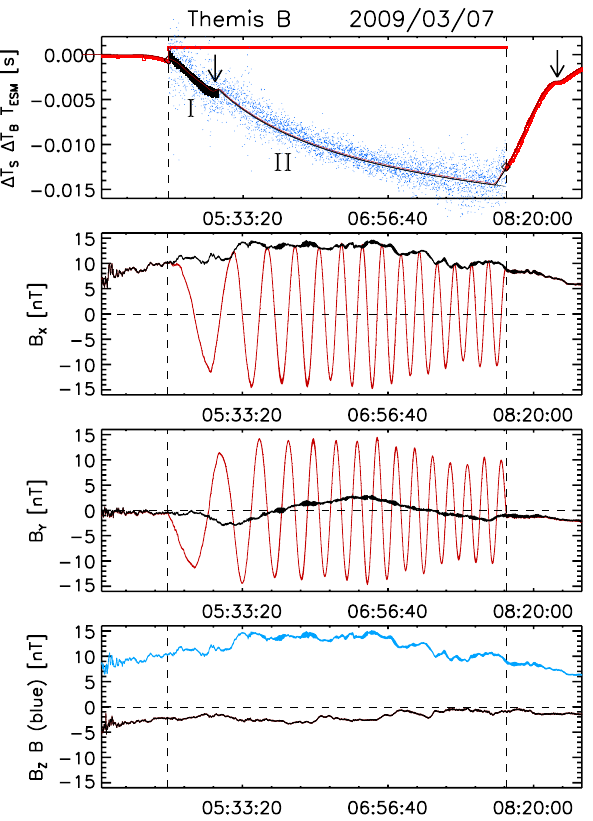
Fig. 2. Eclipse-spin model (ESM) and its application to despin mag- netic field data. The eclipse time interval is delimited by the dashed lines. Top panel: difference of the spin period to the reference value before eclipse: 1T S (thick red line) from Sun sensor, 1T B (black and blue points) from magnetometer measurements and T ESM (thin red line in the eclipse) eclipse spin model. I and II denote the inter- val of short and long eclipses and the arrow point to the shoulder in between. Lower 3 panels: magnetic field in spacecraft system; red: despun with constant T S and black: despun with T ESM . The mag- nitude of the field B (blue) is shown in the bottom panel together with the component along the spin axis B Z